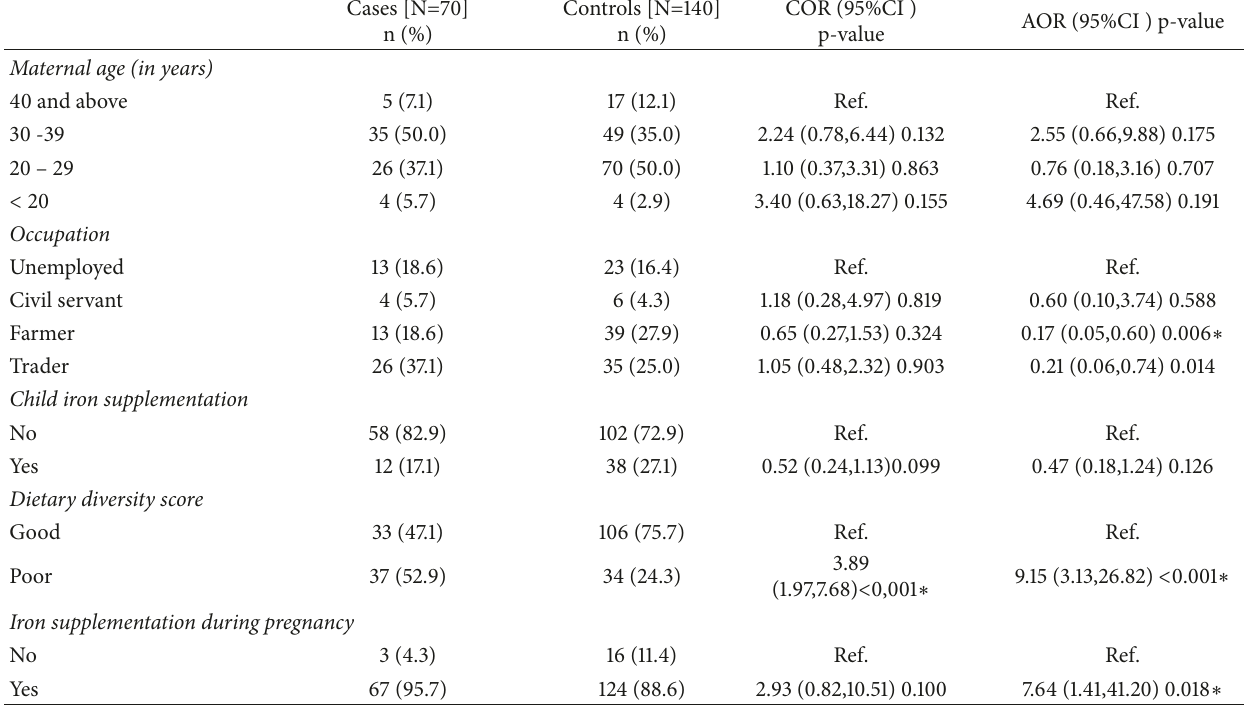
Table 3: A conditional logistic regression showing association between anaemia and biologic, intermediate, and underlying